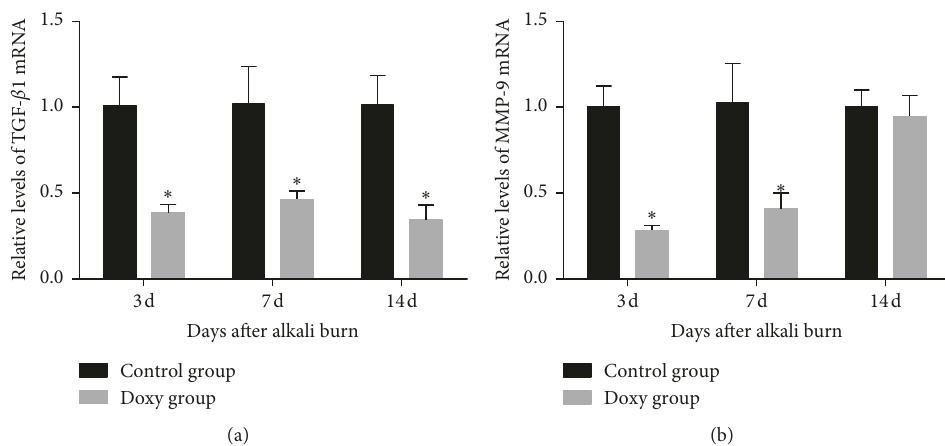
Figure 3: Real-time PCR of the relative expression of transforming growth factor- β 1 (TGF- β 1) (a) and matrix metalloproteinase-9 (MMP- 9) (b) mRNA in the doxycycline and control group 3, 7, and 14 days after corneal alkali burn. Compared with the control group, TGF- β 1 and MMP-9 mRNA expression in the doxycycline group were significantly decreased 3 and 7 days after corneal alkali burn, but just TGF- β 1 mRNA expression decreased on day 14 after injury ( P < 0 . 05). ∗ Statistically significant; data are expressed as mean ± SD, n � 8.